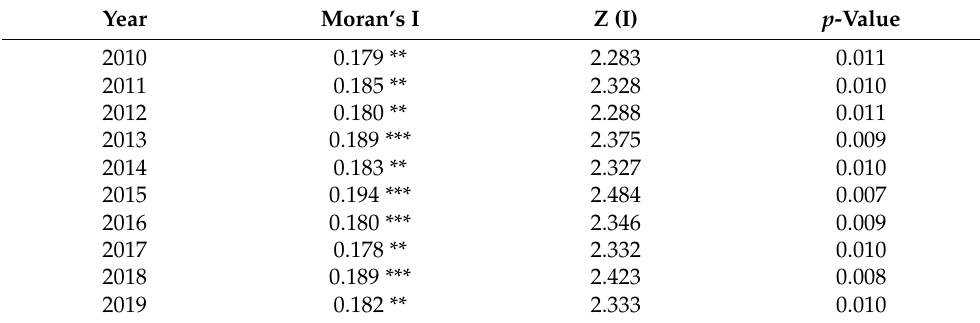
Table 2. Spatial correlation test of carbon dioxide (CO 2 ) emissions in China from 2010 to